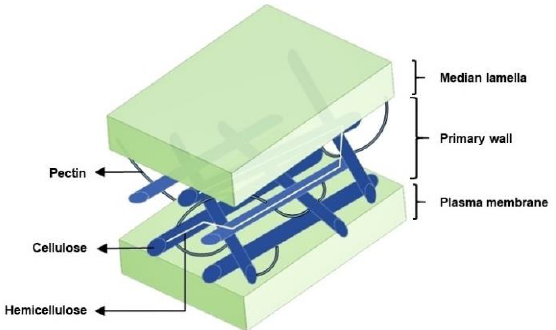
Figure 1. The cell wall of primary plants. Adapted from Raven et al. [23].